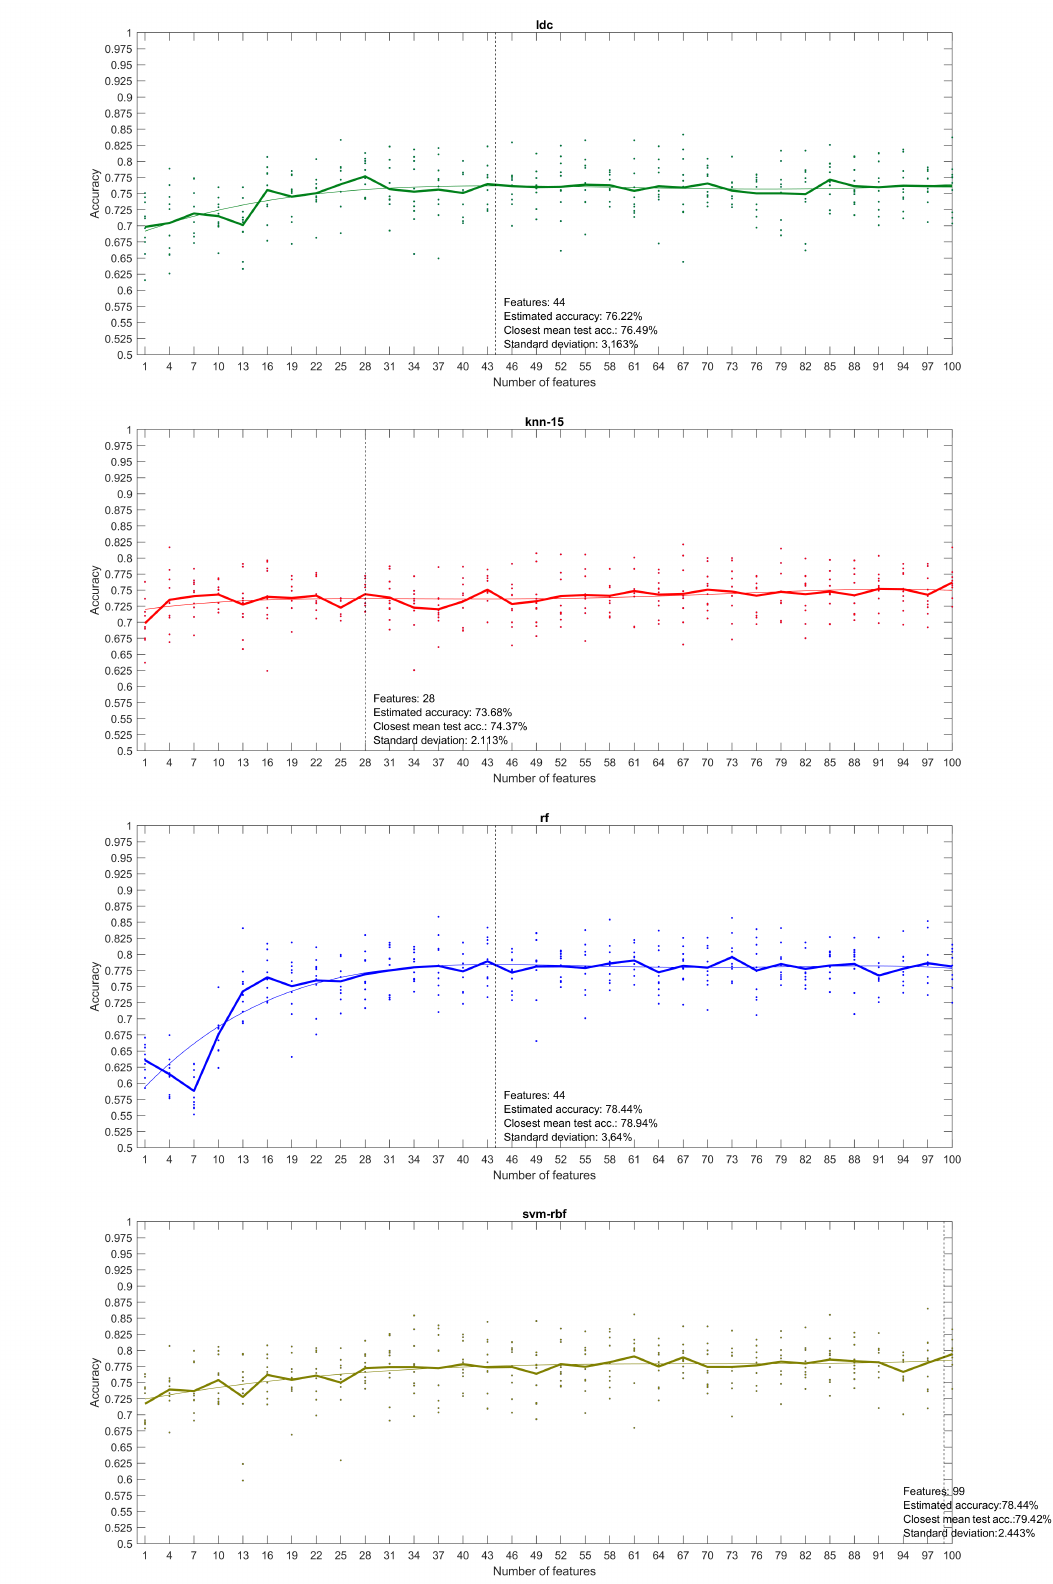
Figure 12. DRT cross validation training results per feature subset and fitted curve used to select the best